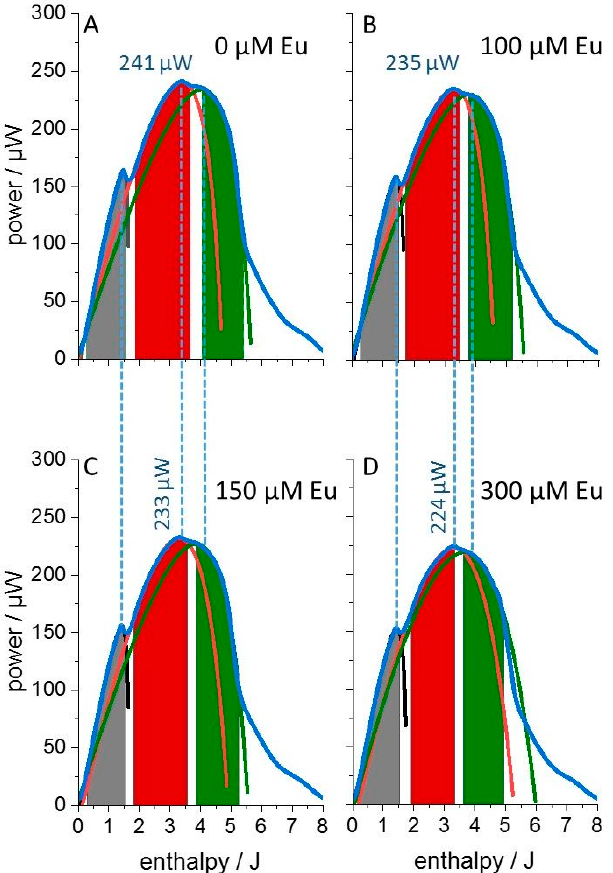
Figure 2. Enthalpy plots of thermograms from L. lactis cultures. The medium without Eu ( A ) exhibited an initial growth rate r i = 0.47 h − 1 . ( B ) Culture supplemented with 100 µ M 153 Eu ( r i = 0.43 h − 1 ) serving as reference for the experiments with 152 Eu. The same data are displayed as in Figure 1. ( C ) and ( D ) show the metabolic activity in the presence of 150 and 300 µ M 153 Eu, respectively, accompanied by a further decrease in the peak metabolic power. Shaded areas mark the data ranges that were used for the thermogram simulation via dAR-TS for each metabolic phase (first, second, third phase in gray, red, green, respectively; dotted lines show the full thermogram simulation for completeness). The error range of initial growth rates is ± 8% when the fitted curve is allowed to adopt a root mean square deviation of ± 2% from the raw data. The displayed fits have a rmsd of less than 1% from the raw data within the fitted shaded